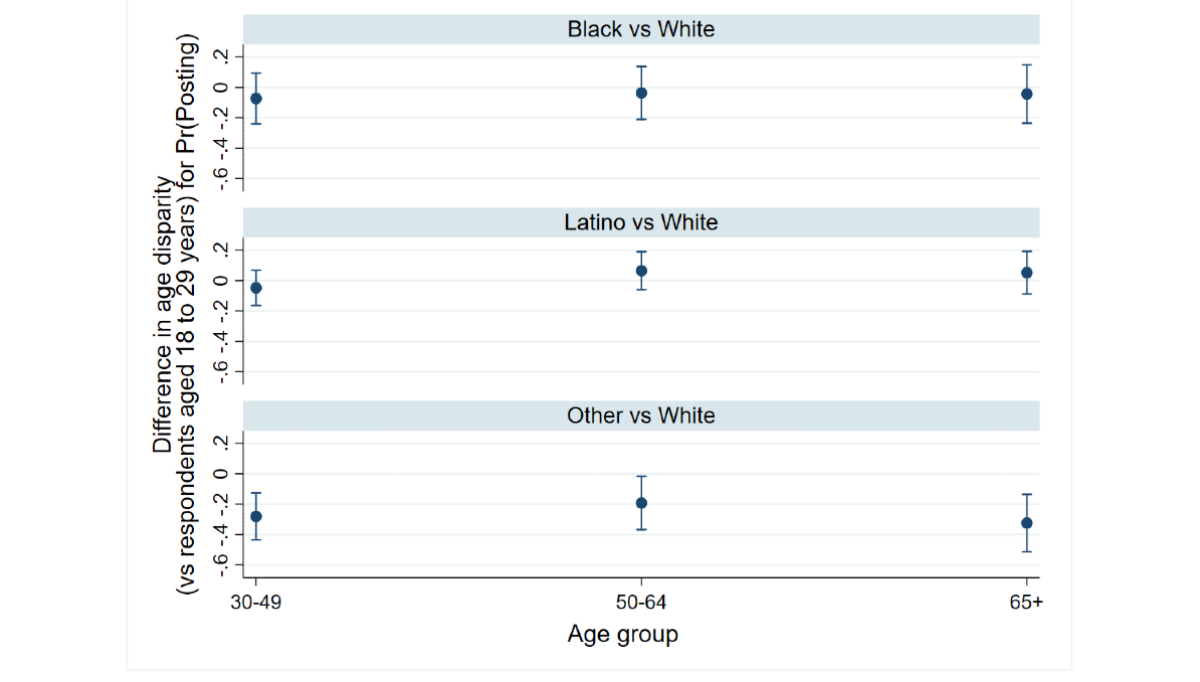
Figure 4 continues the summary of the intersections between race and age by displaying the additional contributions of race